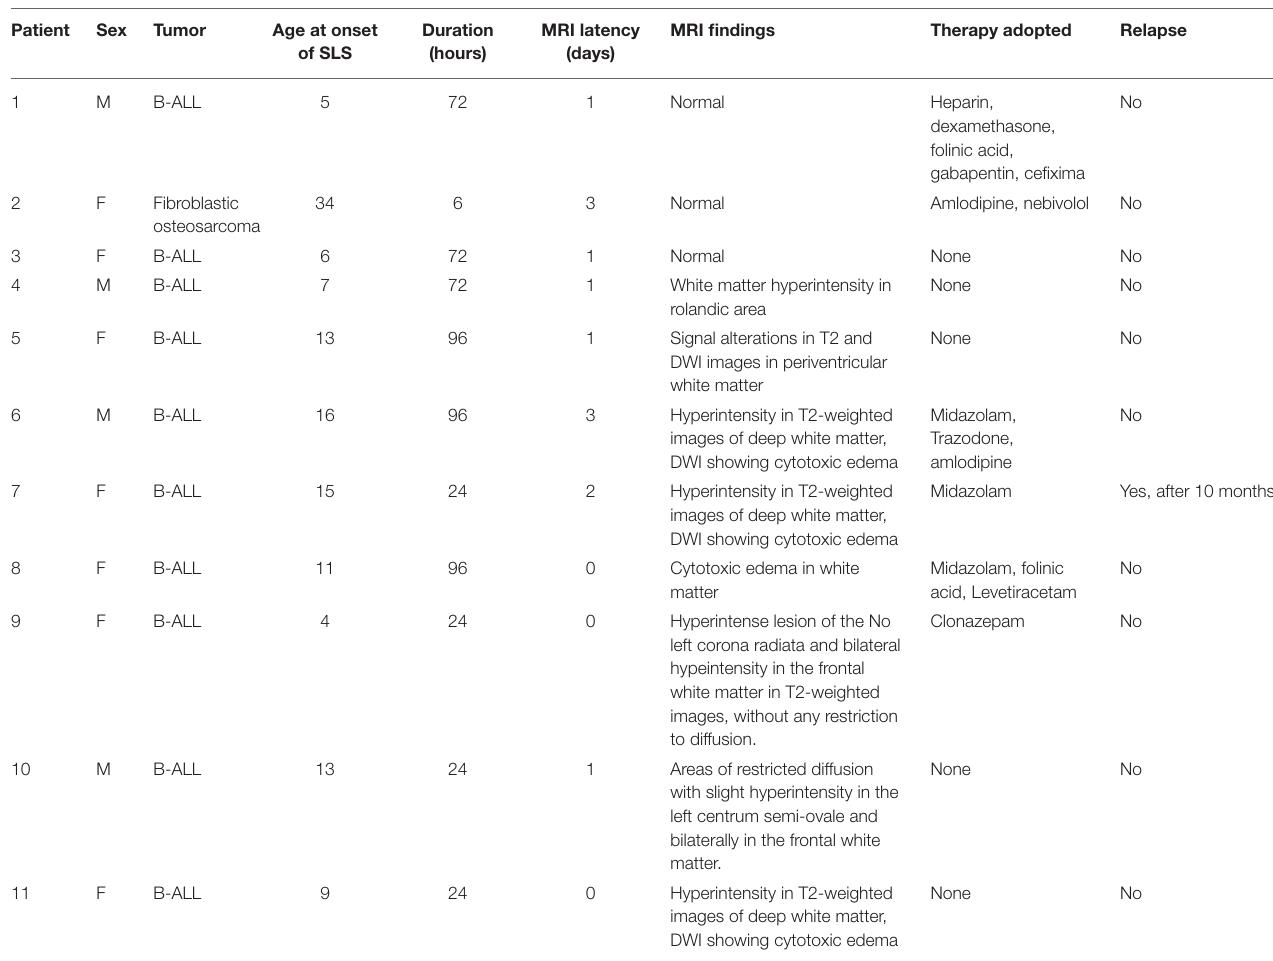
TABLE 3 | Main clinical features of our study cohort.